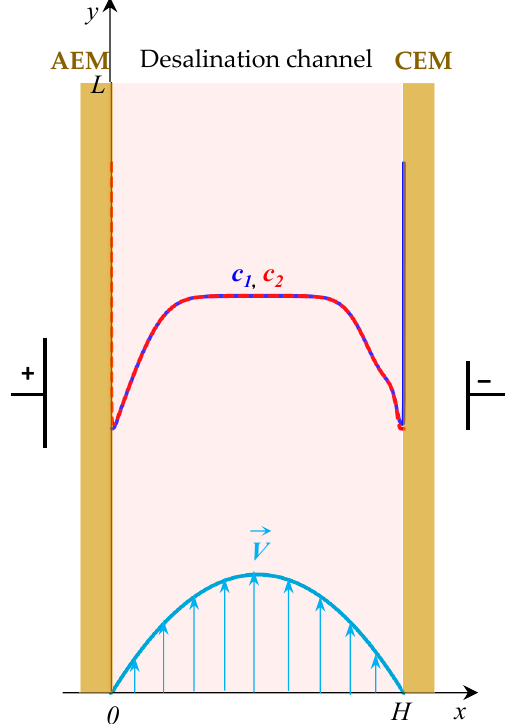
Figure 2. Schematic representation of the simulated system: shown is the desalination channel formed between the anion exchange (AEM) and cation exchange (CEM) membranes; schematically shown is the concentration profiles of cations ( c 1 , solid line) and anions ( c 2 , dotted line) in the desalination channel, the velocity of forced electrolyte flow at the inlet to the channel V